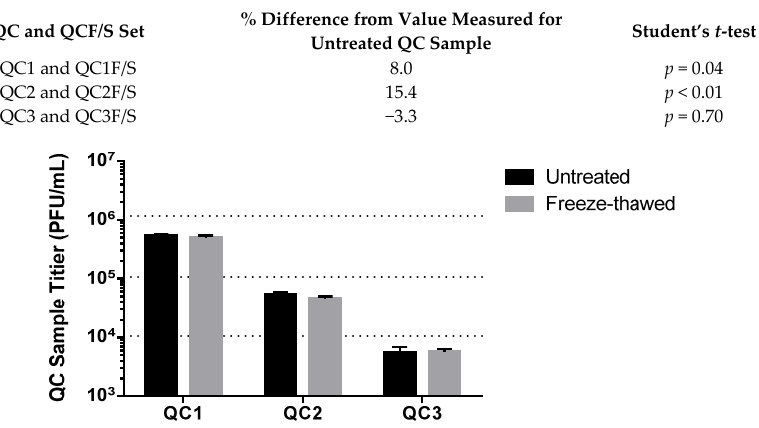
Figure 3. Freeze-thaw treated (designated as F/S) and untreated quality control QC samples 1-3 have Figure 3. Freeze ‐ thaw treated (designated as F/S) and untreated quality control QC samples 1 ‐ 3 have very similar measured titers in the EBOV plaque very similar measured titers in the EBOV plaque assay.